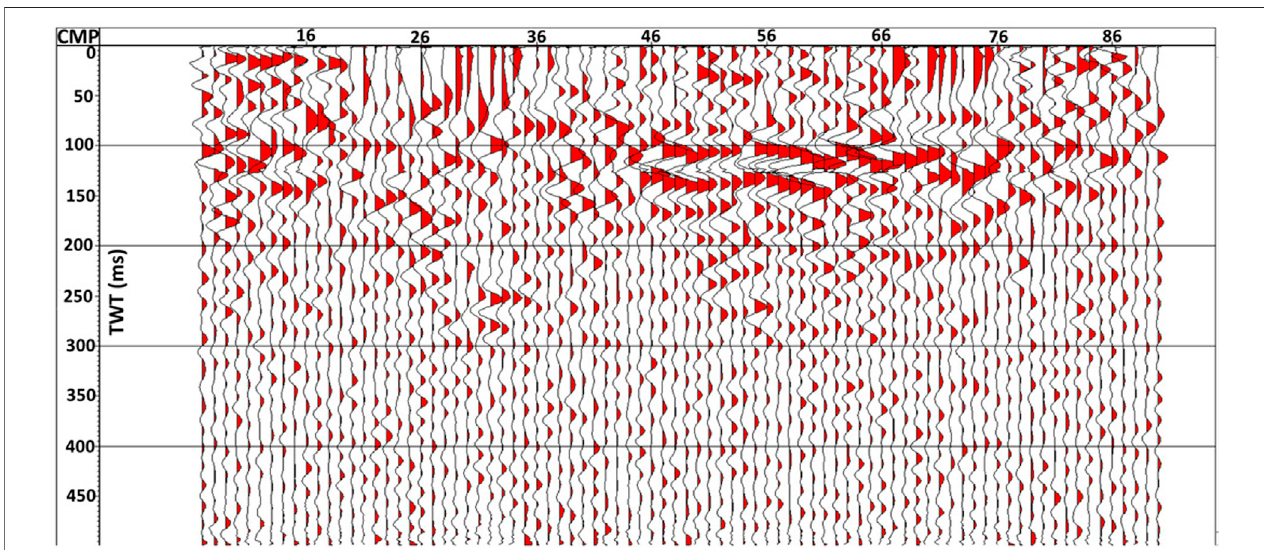
FIGURE 6 | The post-stack seismic section after using Kirchhoff migration that was used for the spatial correction to relocate different geological features to their real position in time and space.